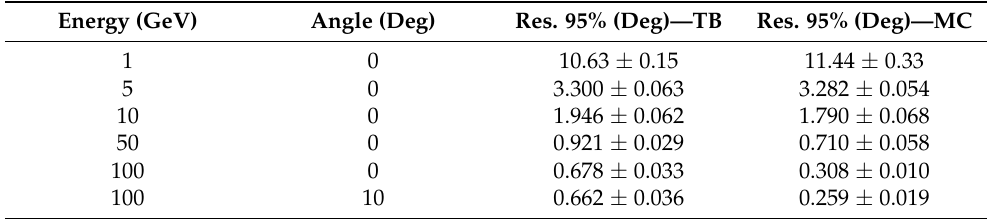
Table 2. Summary of results: XZ angular resolution from test beam (TB) and Monte Carlo (MC) data for 95% PSF (derived from [7]). Energy (GeV) Angle